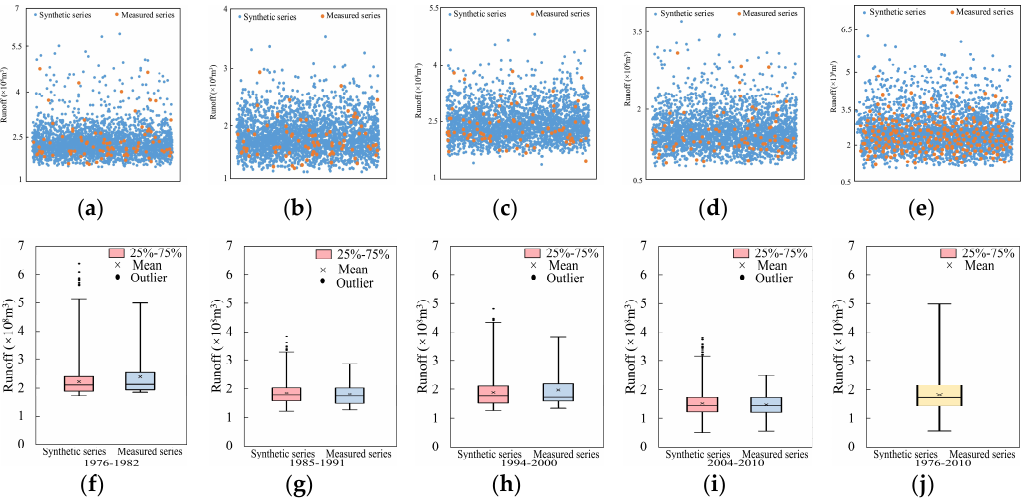
Figure 14. Scatter diagram ( a – d ) and boxplots ( f – i ) of the synthetic series and measured series in four segments at Gaojiabao gauge; ( e ) a scatter diagram of all the synthetic data and the whole original measured data; ( j ) the boxplots of the whole series.